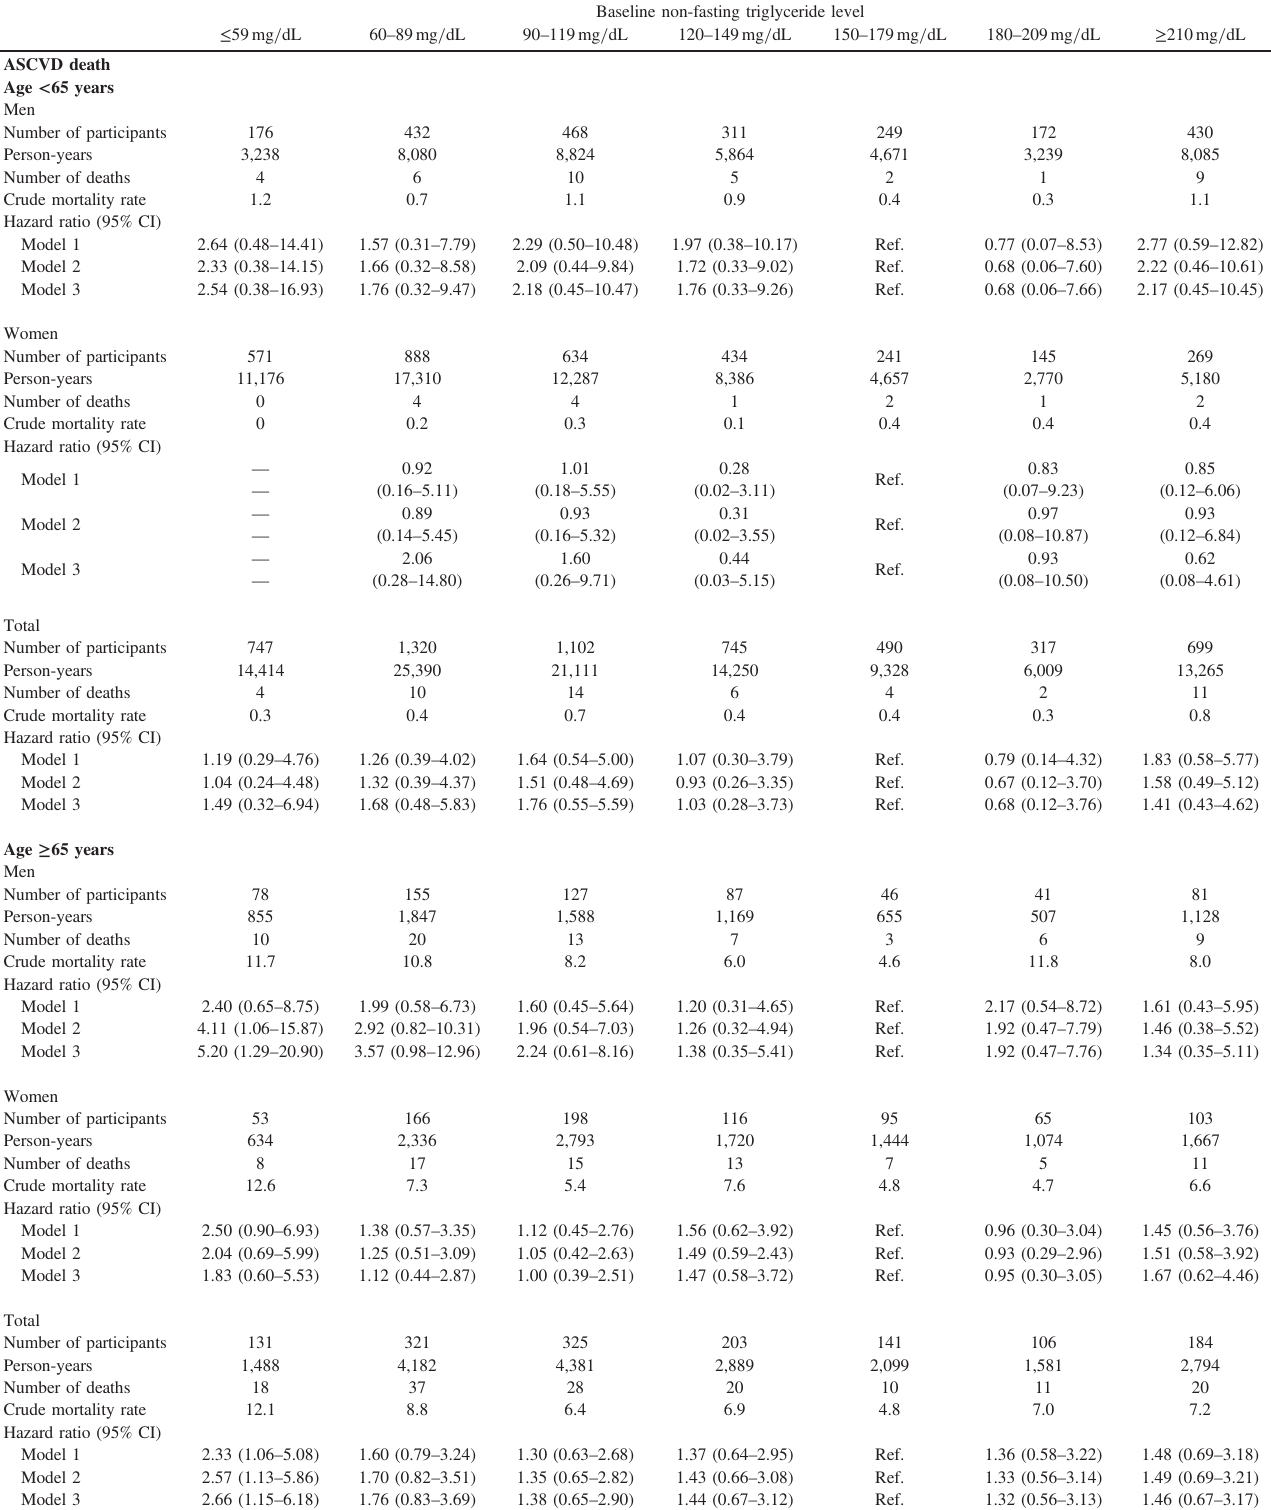
Table 6. Crude mortality rates and hazard ratios for ASCVD mortality according to non-fasting triglyceride category strati fi ed by age < 65 and ; 65